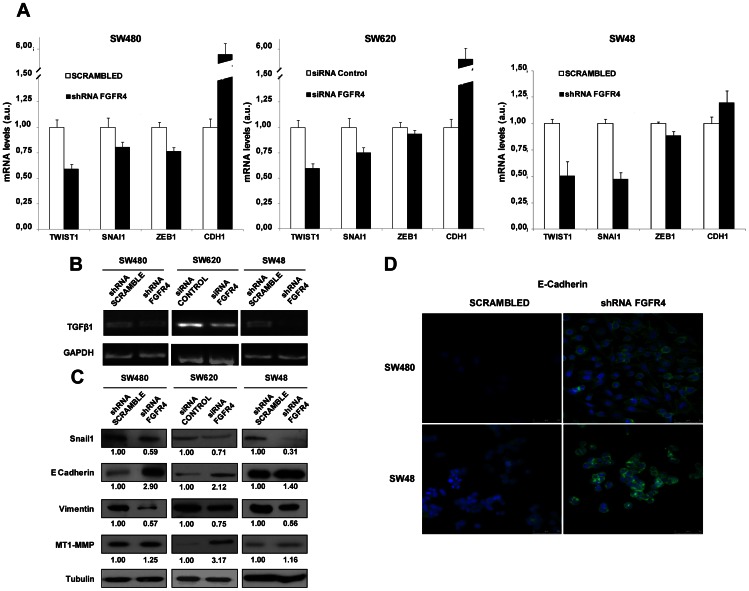
Alterations in EMT inducers after FGFR4-silencing.A. cDNA synthesized from total RNA from stably and transiently-silenced and control cells was subjected to qRT-PCR using specific primers for the EMT inducers SNAI1, TWIST1, ZEB1 and CDH1, using GAPDH for normalization. Data represent the median ± SD of two experiments. B. Same cDNA was subjected to semi-quantitative RT-PCR analysis to amplify TGFβ1, using GAPDH as control. C. SW480 and SW48 scrambled and FGFR4-silenced cells were lysed and subjected to WB analysis using specific antibodies against the indicated proteins and EMT markers. The abundance of each protein was quantified by densitometry. Tubulin was used as loading control. D. Immunofluorescence analysis of E-Cadherin in scrambled and silenced SW480 and SW48 cells. DAPI was used for counterstaining of the nucleus in blue. E-Cadherin staining was in green.